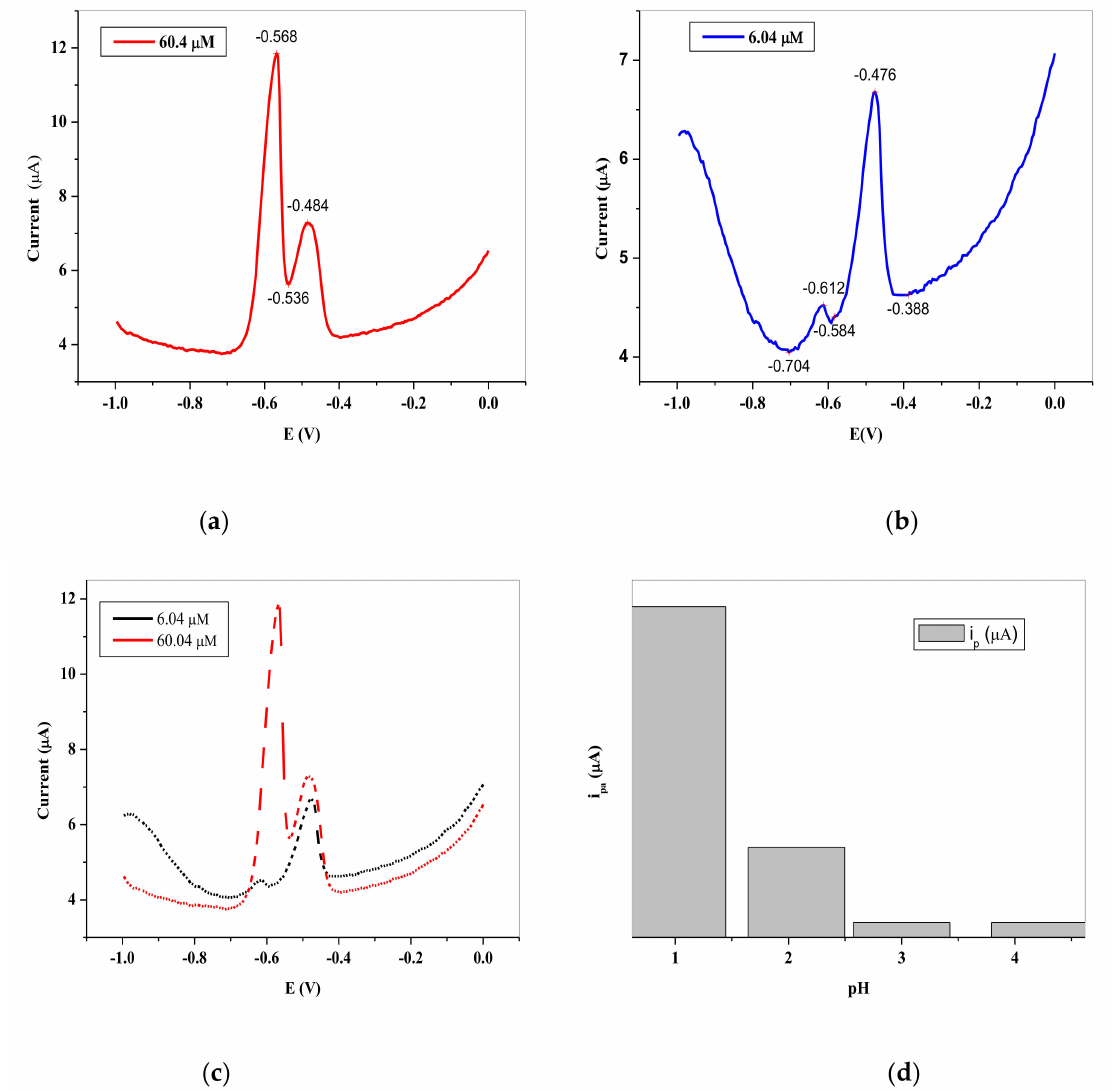
Figure 10. Typical SWV of different Pb 2+ concentrations in 0.1 M HCl electrolyte on SPCE/OPE/BIONPs/PANI, ( a ) 6.04 µ M, ( b ) 60.4 µ M, ( c ) 6.04 µ M and 60.4 µ M ( d ). The influence of pH on the stripping peak current of 6.04 µ M Pb2 + , 1100 mV deposition potential, 30 s deposition time, (Potential vs.